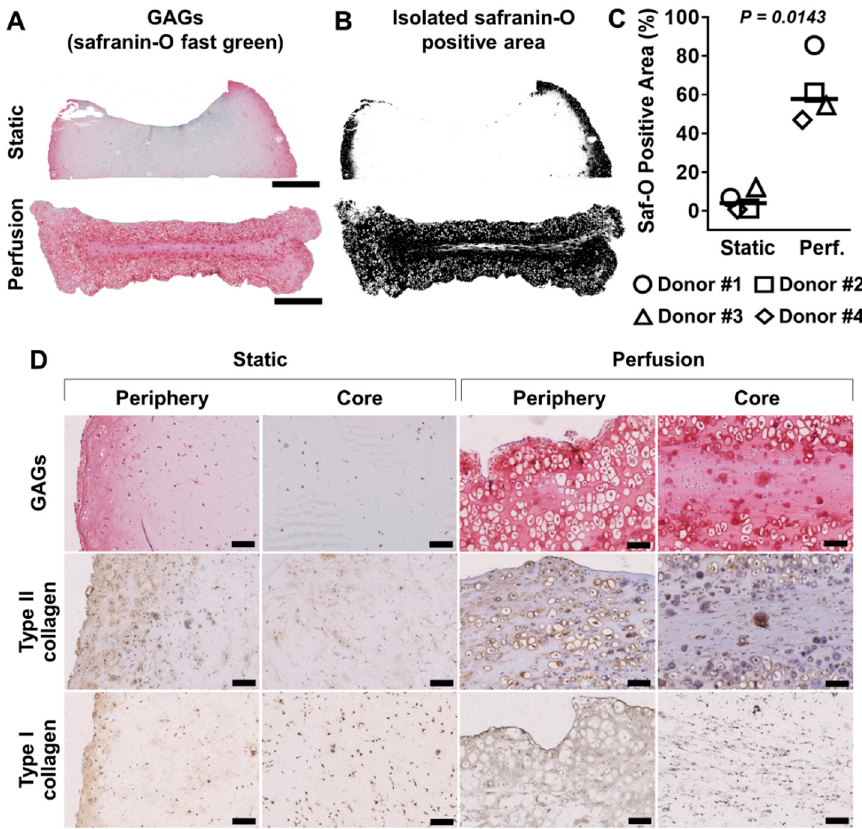
Figure 2. Perfusion enhances cartilage matrix deposition by HACs in fibrin hydrogel. HACs seeded in fibrin hydrogel were cultured in a well plate (static) or a direct perfusion bioreactor in the presence of BIT for 3 weeks. ( A ): Static and perfusion cultures stained for safranin-O fast green to reveal the presence of glycosaminoglycans (GAGs) of sulfated proteoglycans. ( B ): Isolation of safranin-O positive area (orange to red) within the histological sample with the color threshold plugin of ImageJ software. ( C ): Safranin-O positive surface area normalized to the total surface area of the histological section. Each single data point in the dot plot is the mean value of several histological slices; bars represent the median of the data points. ( D ): Representative images of safranin-O fast green staining (GAGs) and collagen types I and II immunohistochemical staining of the engineered cartilage constructs. The level of significance of the statistical analysis ( p -value) is indicated (scale bars: A = 1 mm, D = 100 µm) ( n = 4).